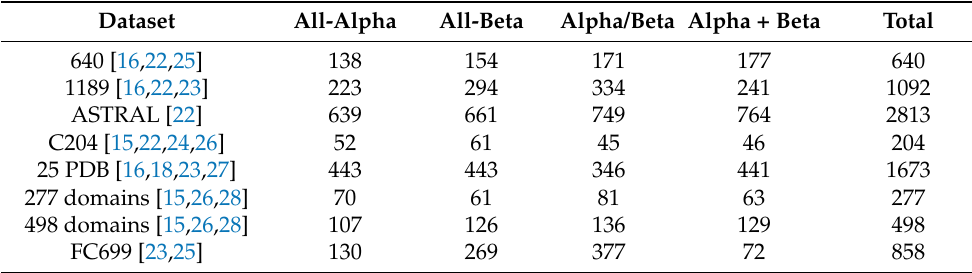
Table 1. Typical protein datasets with four categories used for benchmarking. The number of proteins in each category and the total number of proteins in a dataset are